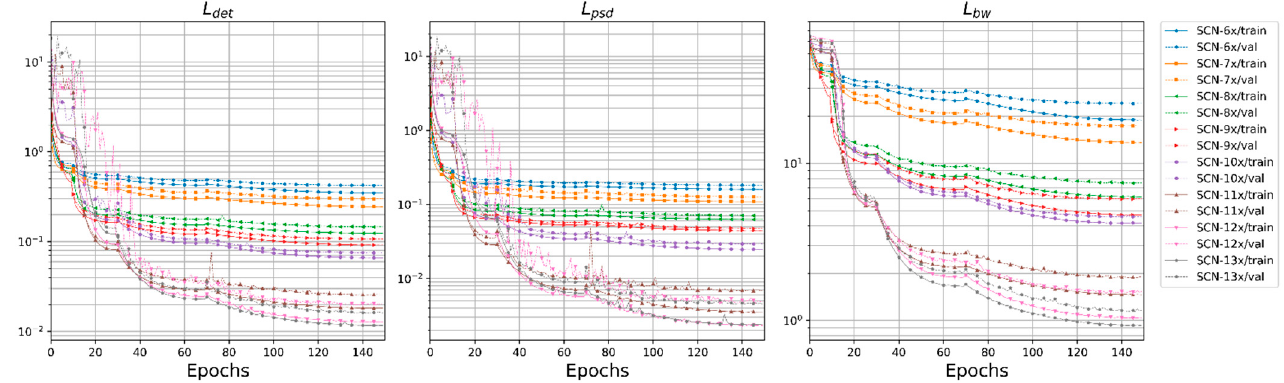
Figure 6. The training and validation loss of different scales of SCN, where L det is the total loss, L psd is the PSD regression loss, and L bw is the BW regression loss.